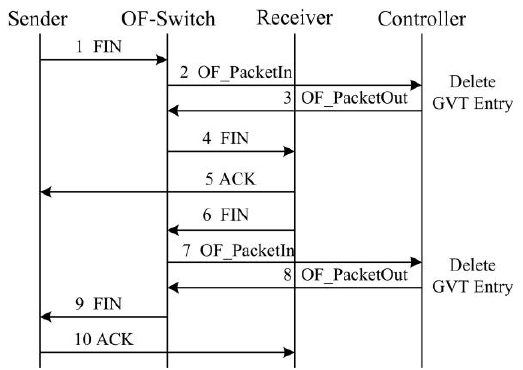
Figure 6. GVT entry deletion with the TCP termination procedure.